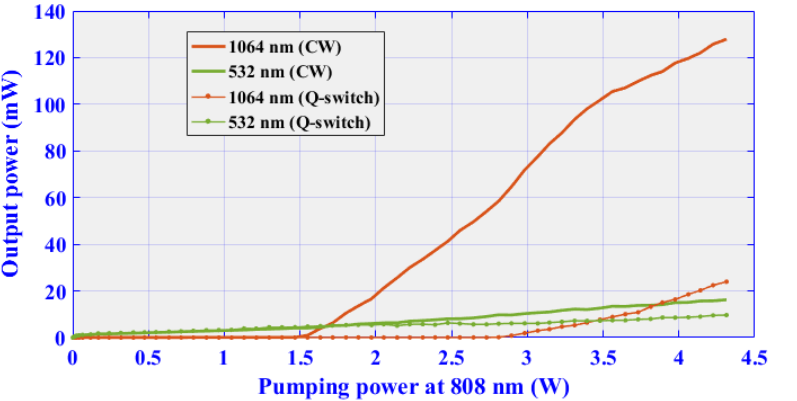
Figure 6. Power of the laser with KTP